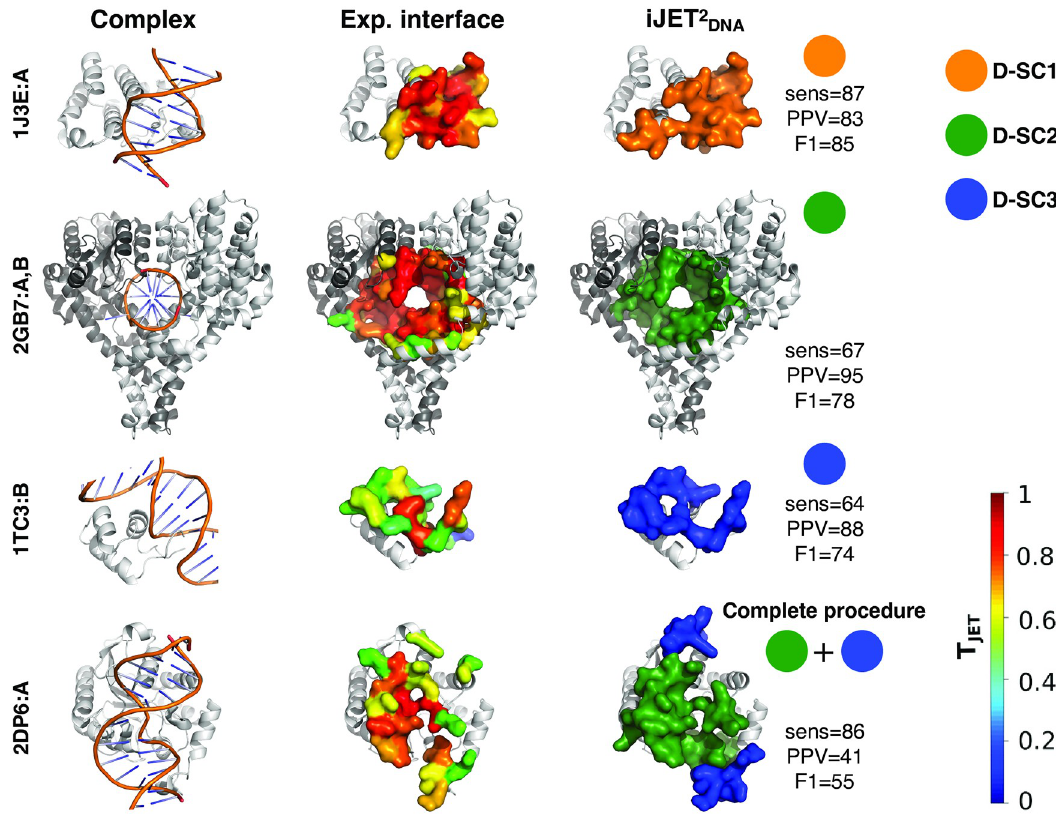
Fig 3. Examples of DNA-binding sites predicted by iJET 2 proteins of interest (greyscaled colored chains) and the DNA (orange) are represented as cartoons. In second and third columns, the experimental and predicted DNA-binding sites are displayed as opaque surfaces, respectively. The experimental interface residues are colored according to conservation levels (T JET values) computed by iJET 2 runs out of 10, are colored according to the scoring scheme: D-SC1 in orange, D-SC2 in dark green and D-SC3 in blue. Statistical performance values are given in